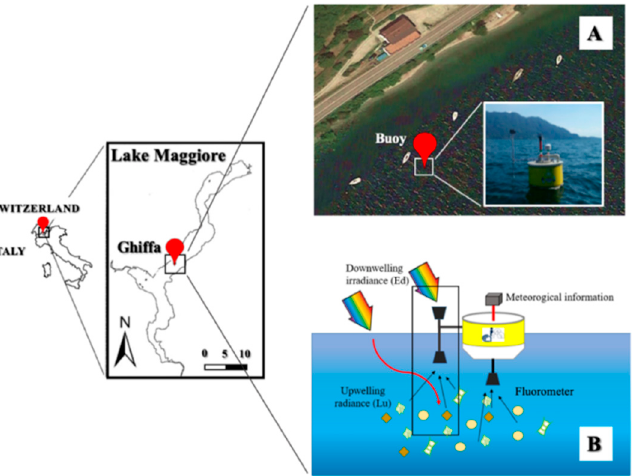
Figure 1. Location of the experimental measurements in the Lake Maggiore. ( A ) (top right) show the buoy on which instruments for hyperspectral and continuous measurements were mounted. ( B ) (bottom right) display the experimental set-up. The water samples have been collected manually close enough to the buoy, to improve the matching between the water samples and the continuous spectral